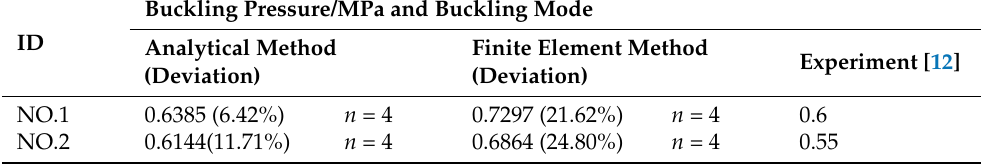
Table 4. Analytical results.